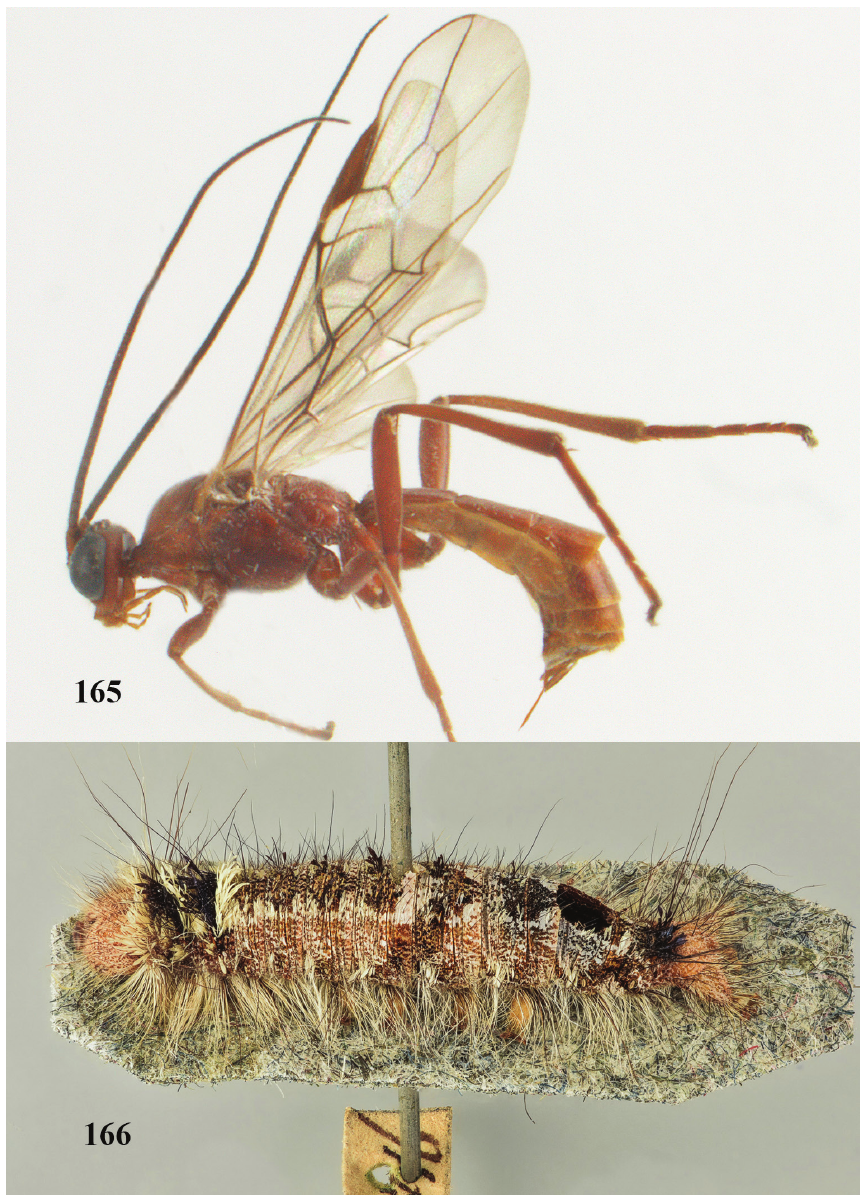
Figures 165–166. Aleiodes esenbeckii (Hartig), ♀ , Spain, Mallorca. 165 habitus lateral 166 mummy of Dendrolimus pini (Linnaeus) of holotype of A. esenbeckii from Germany.